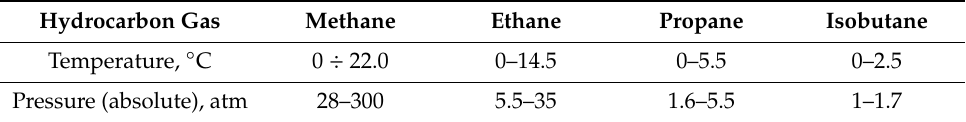
Table 1. Critical parameters of the hydrate formation of natural gases.